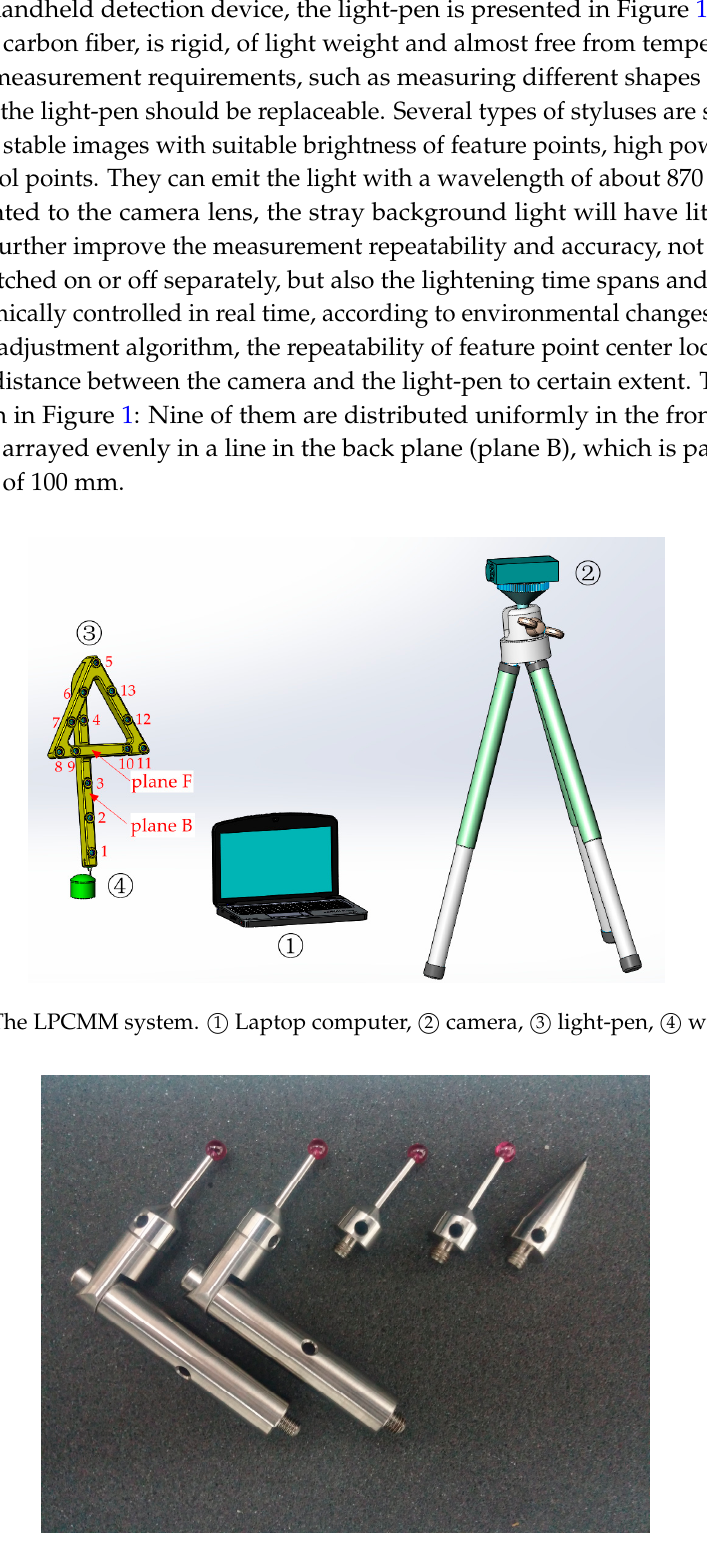
Figure 2. Light-pen styluses. Figure 2. Light-pen